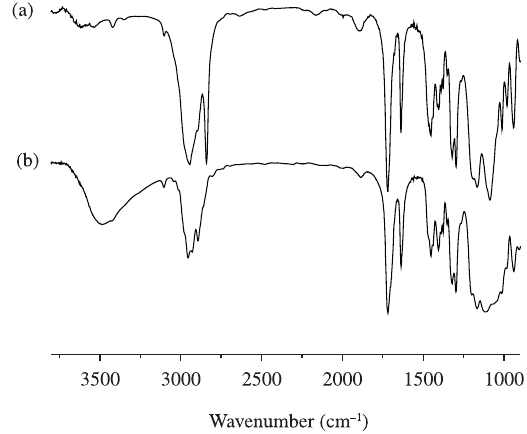
Figure 1. Infrared spectra of (a) MEMO and (b)